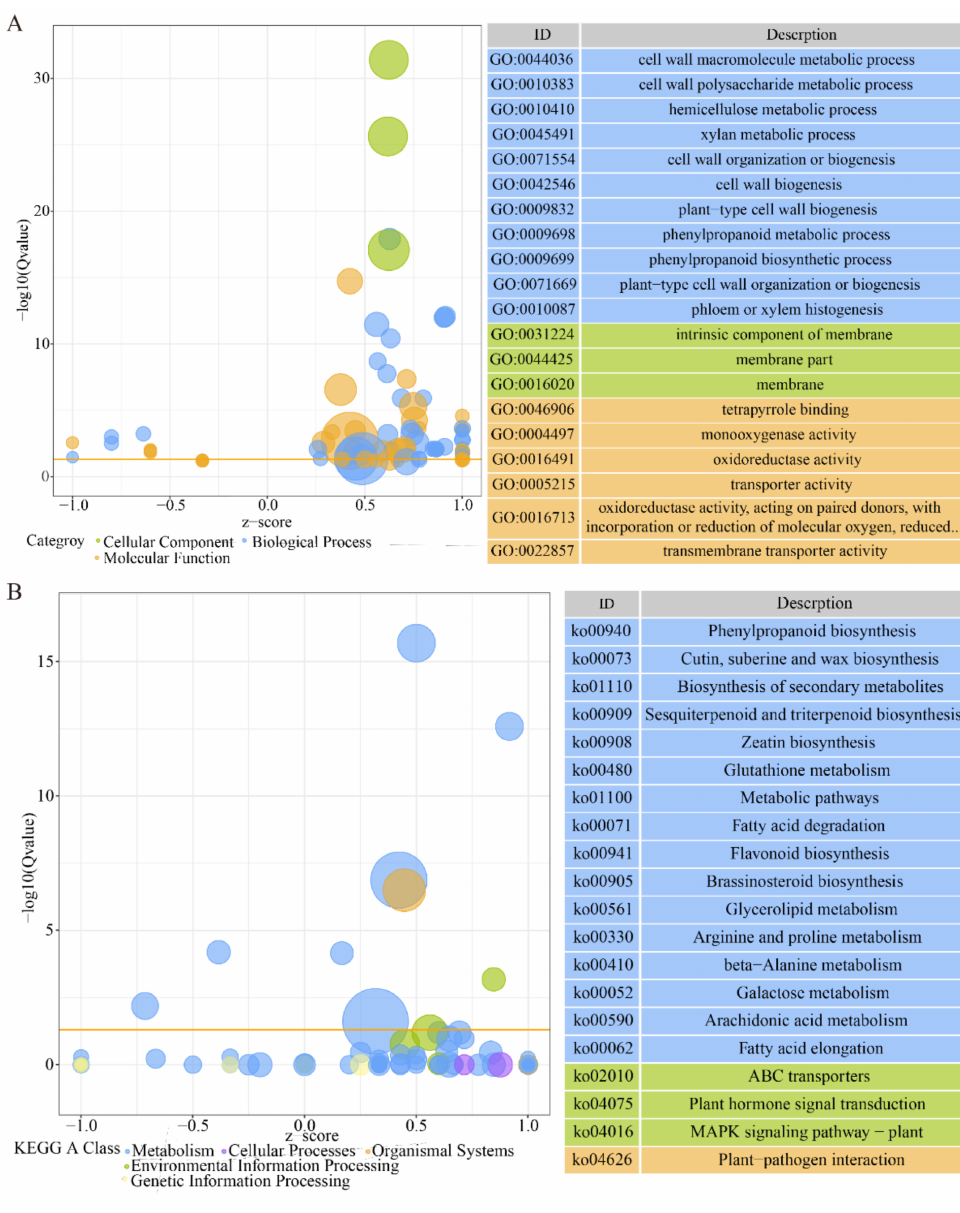
Figure 5. Gene ontology (GO) and Kyoto Encyclopedia of Genes and Genomes (KEGG) enrichment analyses of control and PHS (t18:0, phytosphingosine) samples. ( A , B ) The bubble chart of GO ( A ) and KEGG ( B ) enrichment categories (left panel) and the top 20 GO ( A ) and KEGG ( B ) enrichment categories (right panel) in the control and PHS-treated samples. In the bubble chart, the ordinate axes indicate log10 (Q value), and the abscissa axes indicate z-score (the proportion of the difference between the number of up-regulated and down-regulated genes in the total number of DEGs), the bubble sizes mean the difference between the number of up-regulated and down-regulated genes, and the yellow line represents the threshold value of Q value = 0.05. On the right is a list of the top 20 enrichments with Q values. Different colors represent different category or A class and plot